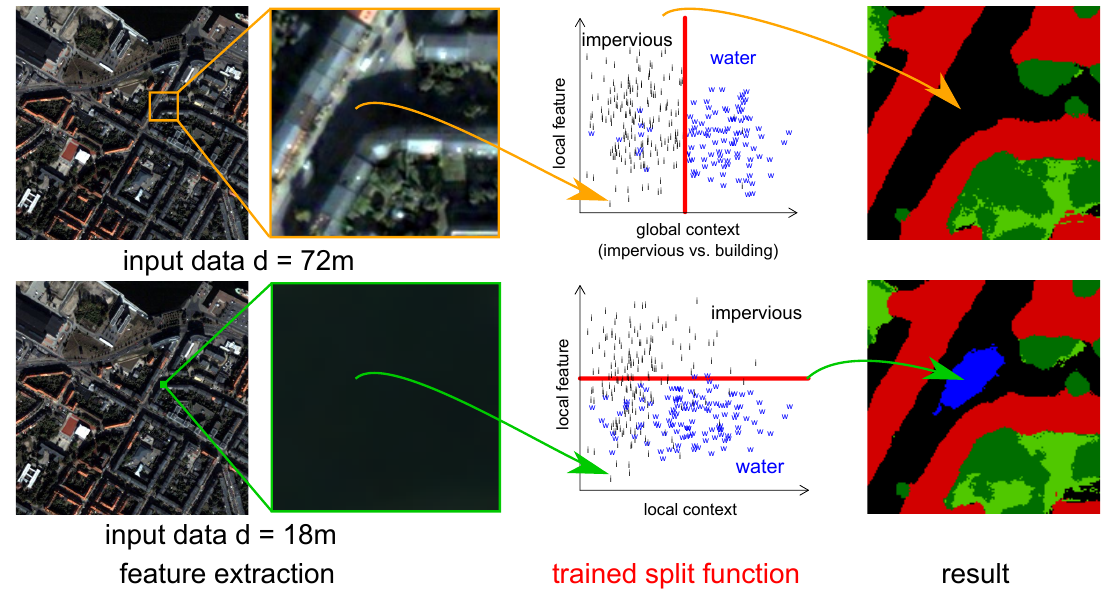
Figure 7: Context vs. no context: first row using contextual features to differ between impervious (road) and water tends to better results than using no contextual features in the second row.